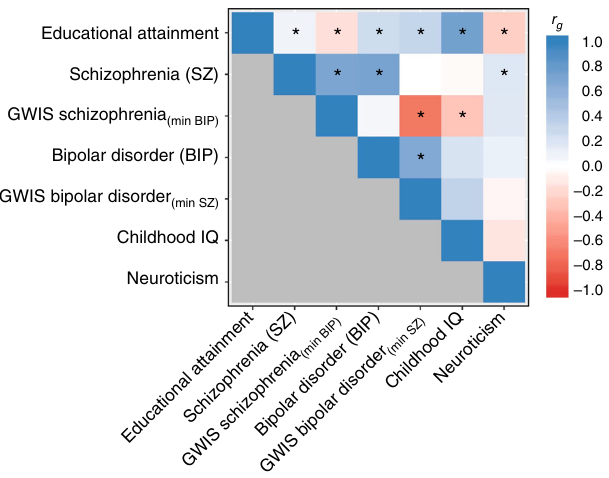
Fig. 3 Genetic correlations of GWAS and GWIS results. Notes: The heatmap displays the genetic correlations across seven sets of GWAS or GWIS summary statistics. Genetic correlations were estimated with LD score regression 42. The colour scale represents the genetic correlations ranging from – 1 (red) to 1 (blue). Asterisks denote signi fi cant genetic correlations at P value <